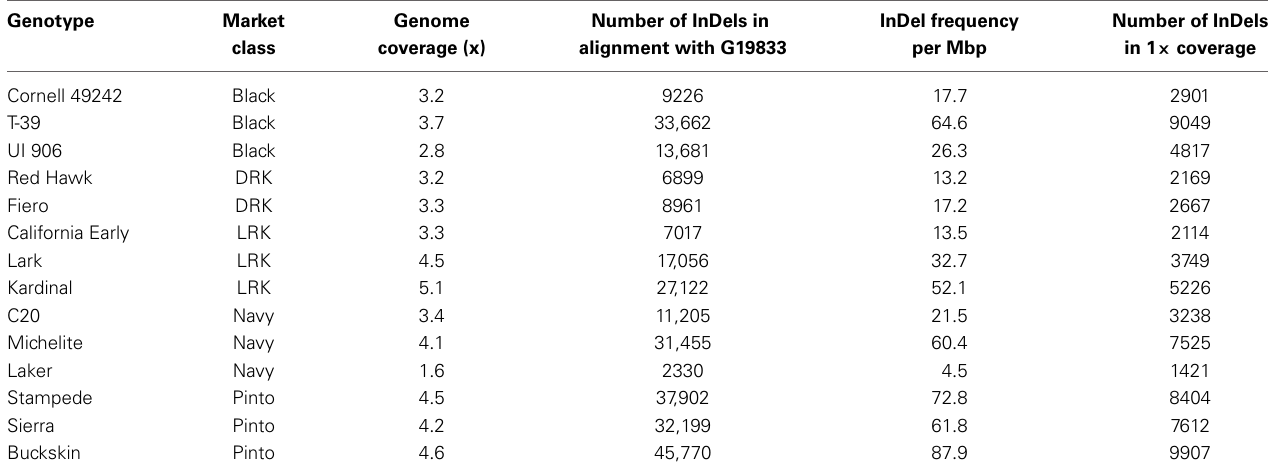
Table 4 | Number and distribution of InDels in each genotype when aligned with G19833.